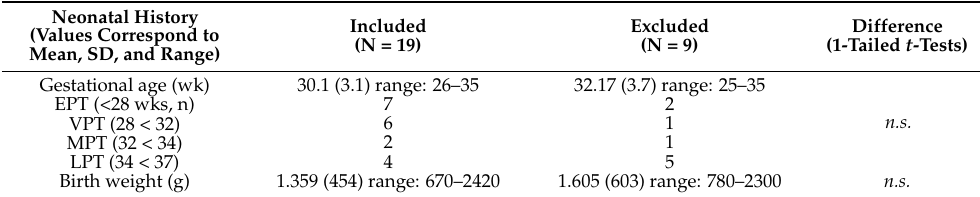
Table 1. Neonatal characteristics of preterm